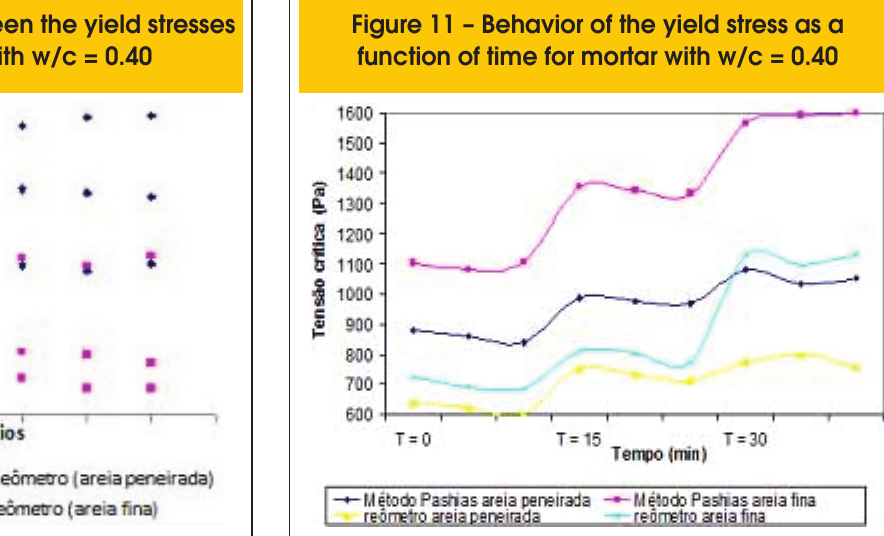
Figure 11 – Behavior of the yield stress as a function of time for mortar with w/c =